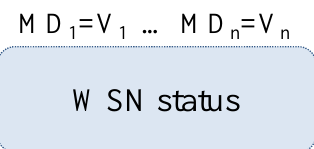
Figure 1. The box metaphor of a context.